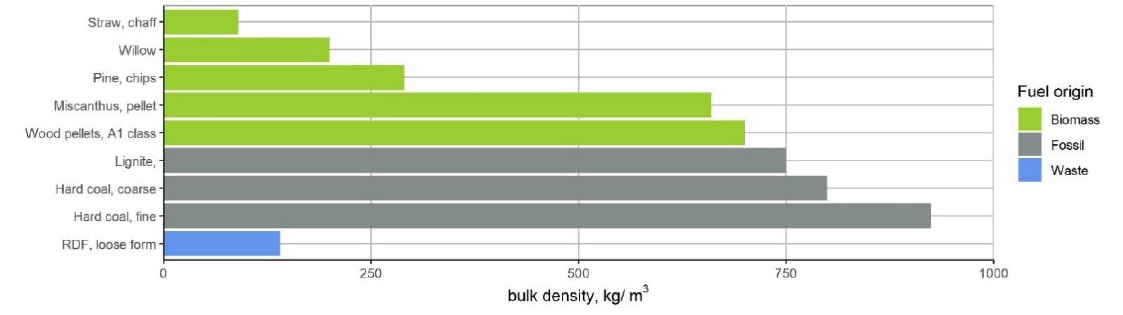
Figure 2. Comparison of bulk densities of fuel materials [32,36–38].